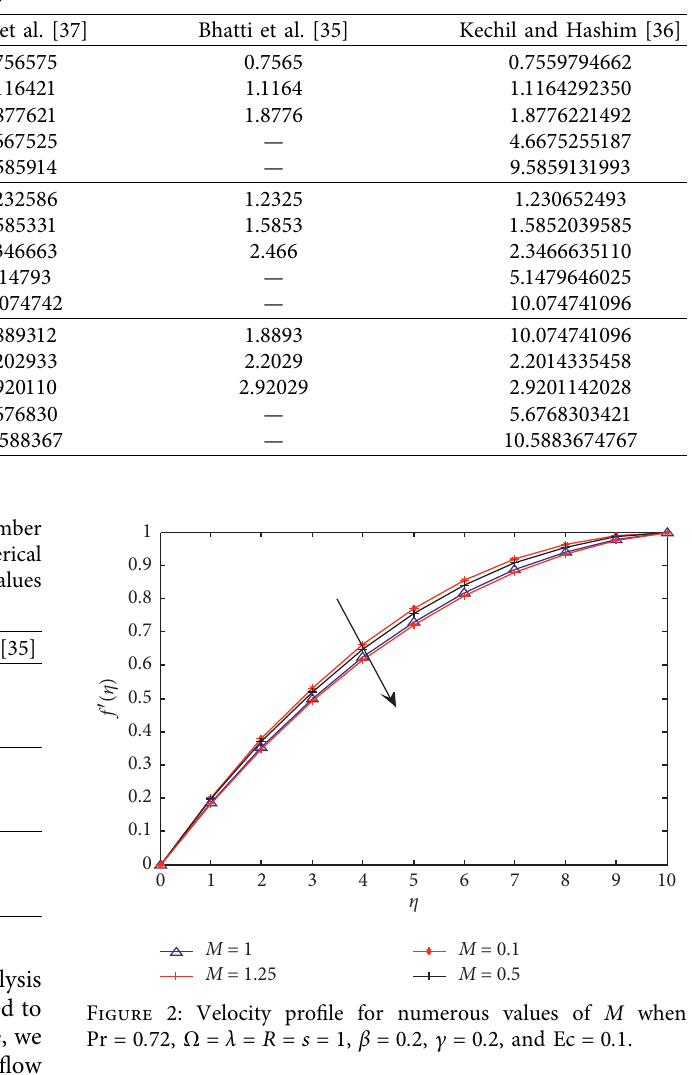
Table 1: Comparison of the values of local skin friction coefficient ( f ″ ( 0 )) obtained by the OHAM and other numerical methods in the existing literature for altered values of M and s whenPr � 1 , β � Ω � 0.